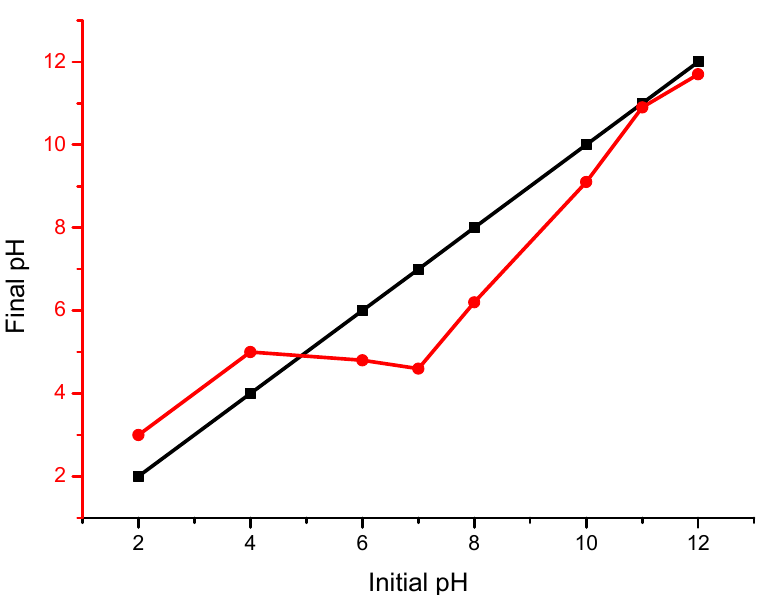
Figure 2. Initial vs. final pH plot for the determination of the pHpzc of the composite in the packed column.